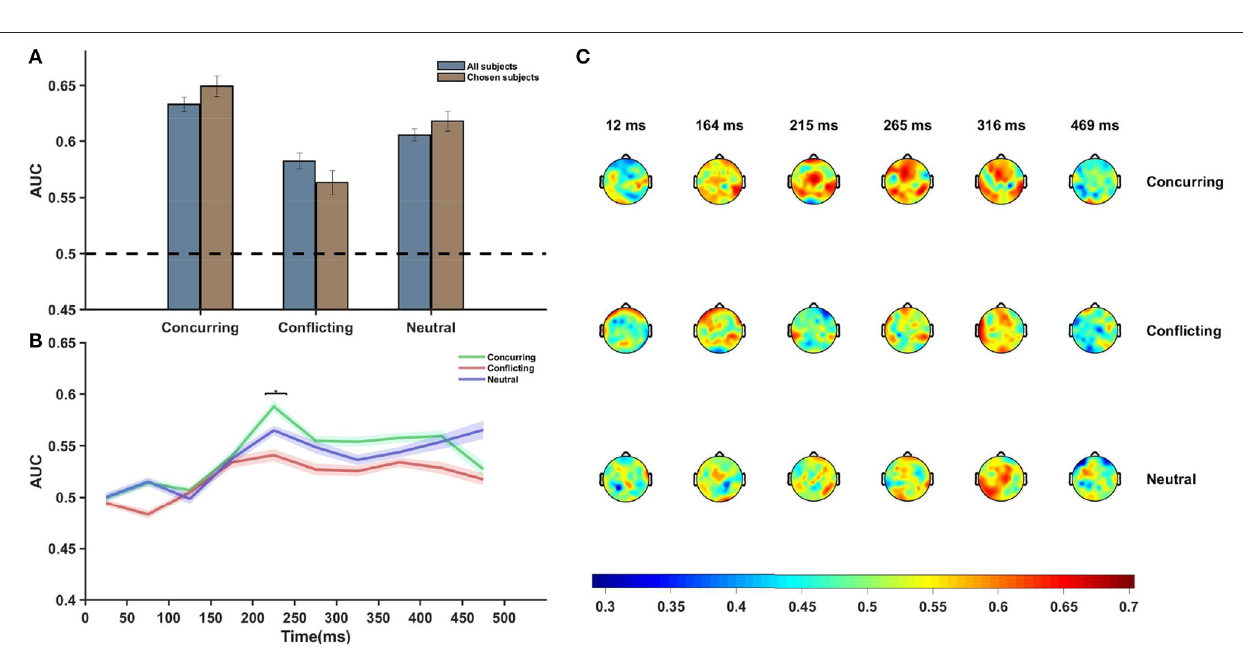
only in the time window 200–250 ms [ p -value (without multiple 0.054, multiple hypothesis test performed across time = points where the classification rates corresponding to concurring trials are more than chance]. On performing similar time- window analysis on the chosen subjects, it was seen